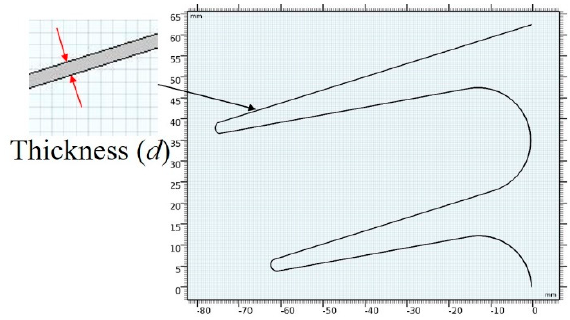
Figure 8. Two-dimensional cross-section of the pollution layer.